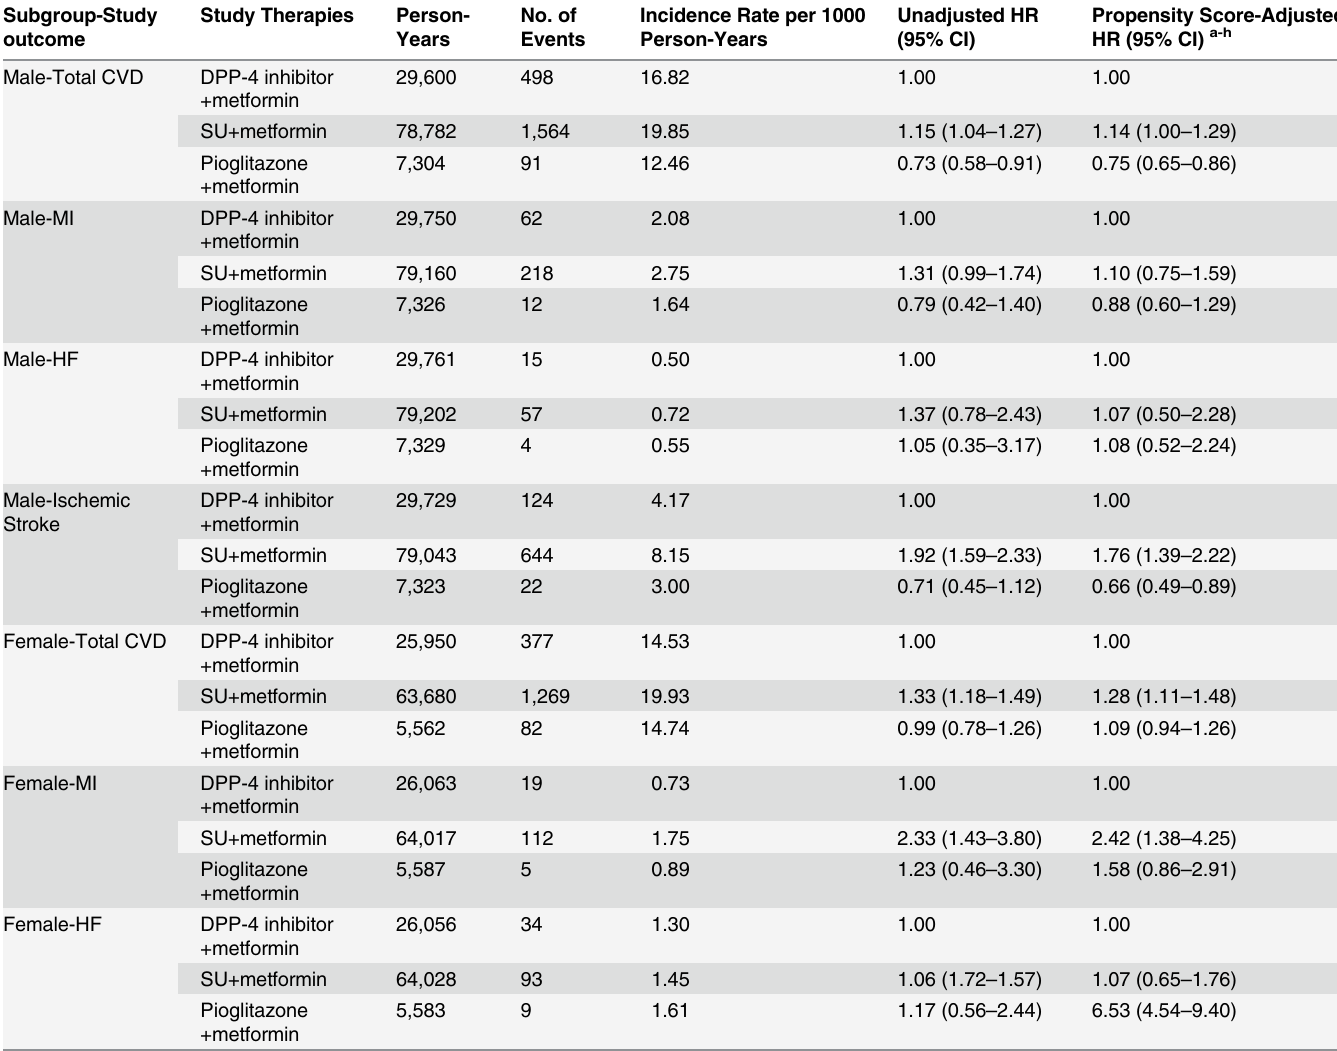
Table 3. Subgroup analyses for total cardiovascular disease, myocardial infarction, heart failure, and ischemic stroke in patients treated with a DPP-4 inhibitor plus metformin vs. sulfonylurea drug plus metformin and pioglitazone plus metformin. Subgroup-Study